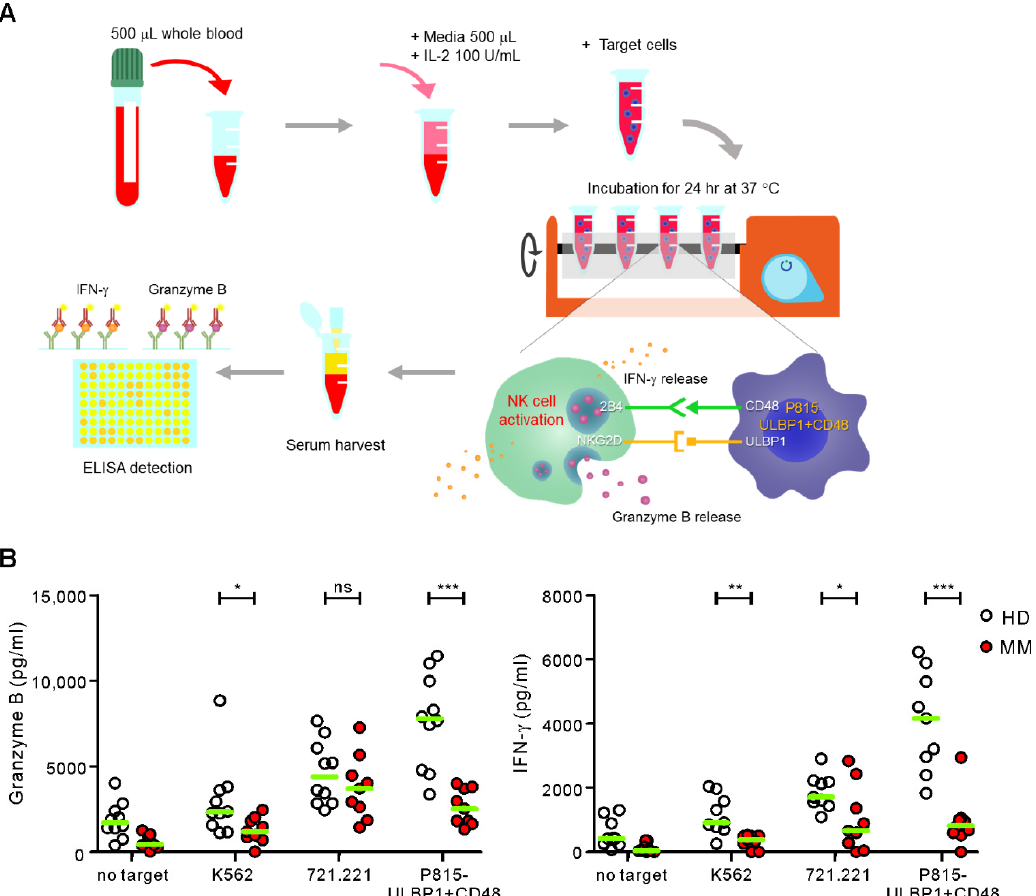
Figure 2. Comparison of NK cell functions between HDs and patients with MM using the whole blood (WB)-based NKA assay. WB samples from the HD group (granzyme B: n = 10; IFN- γ : n = 9) and MM group ( n = 9) were incubated with the indicated target cells in the presence of 100 U / mL IL-2. ( A ) Scheme for NKA measurement using WB-NKA assay. ( B ) Secretion of granzyme B ( left ) and IFN- γ ( right ) into the supernatant was measured by ELISA. Horizontal bars ( green ) indicate the medians. * p < 0.05, ** p < 0.01, and *** p < 0.001; Mann–Whitney U-test.